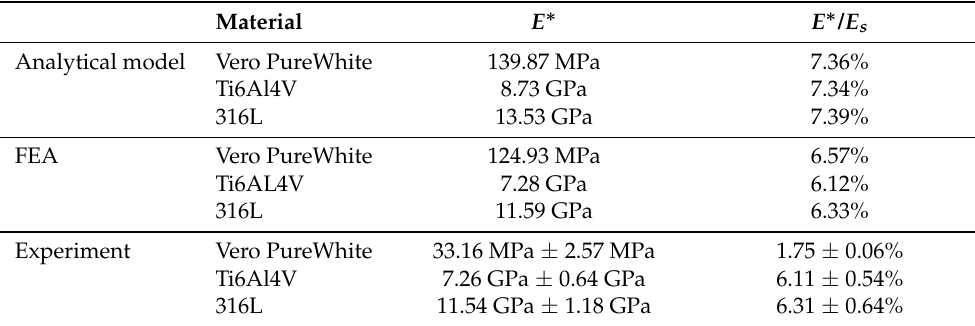
Table 3. Effective Young’s modulus in tension. Comparisons between prediction from analytical, numerical model and experimentally determined values for Stratasys Vero PureWhite, Ti6Al4V, and 316L. E ∗ denotes effective Young’s modulus, and E s is Young’s modulus of the bulk